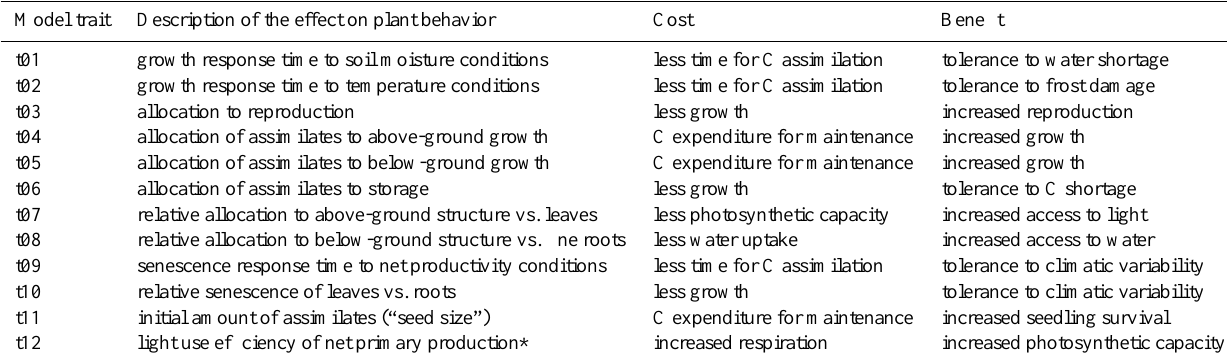
Table 1. Description of the 12 plant functional traits used to define a plant growth strategy (PGS). All traits are associated to costs and benefits in terms of allocation, phenology and